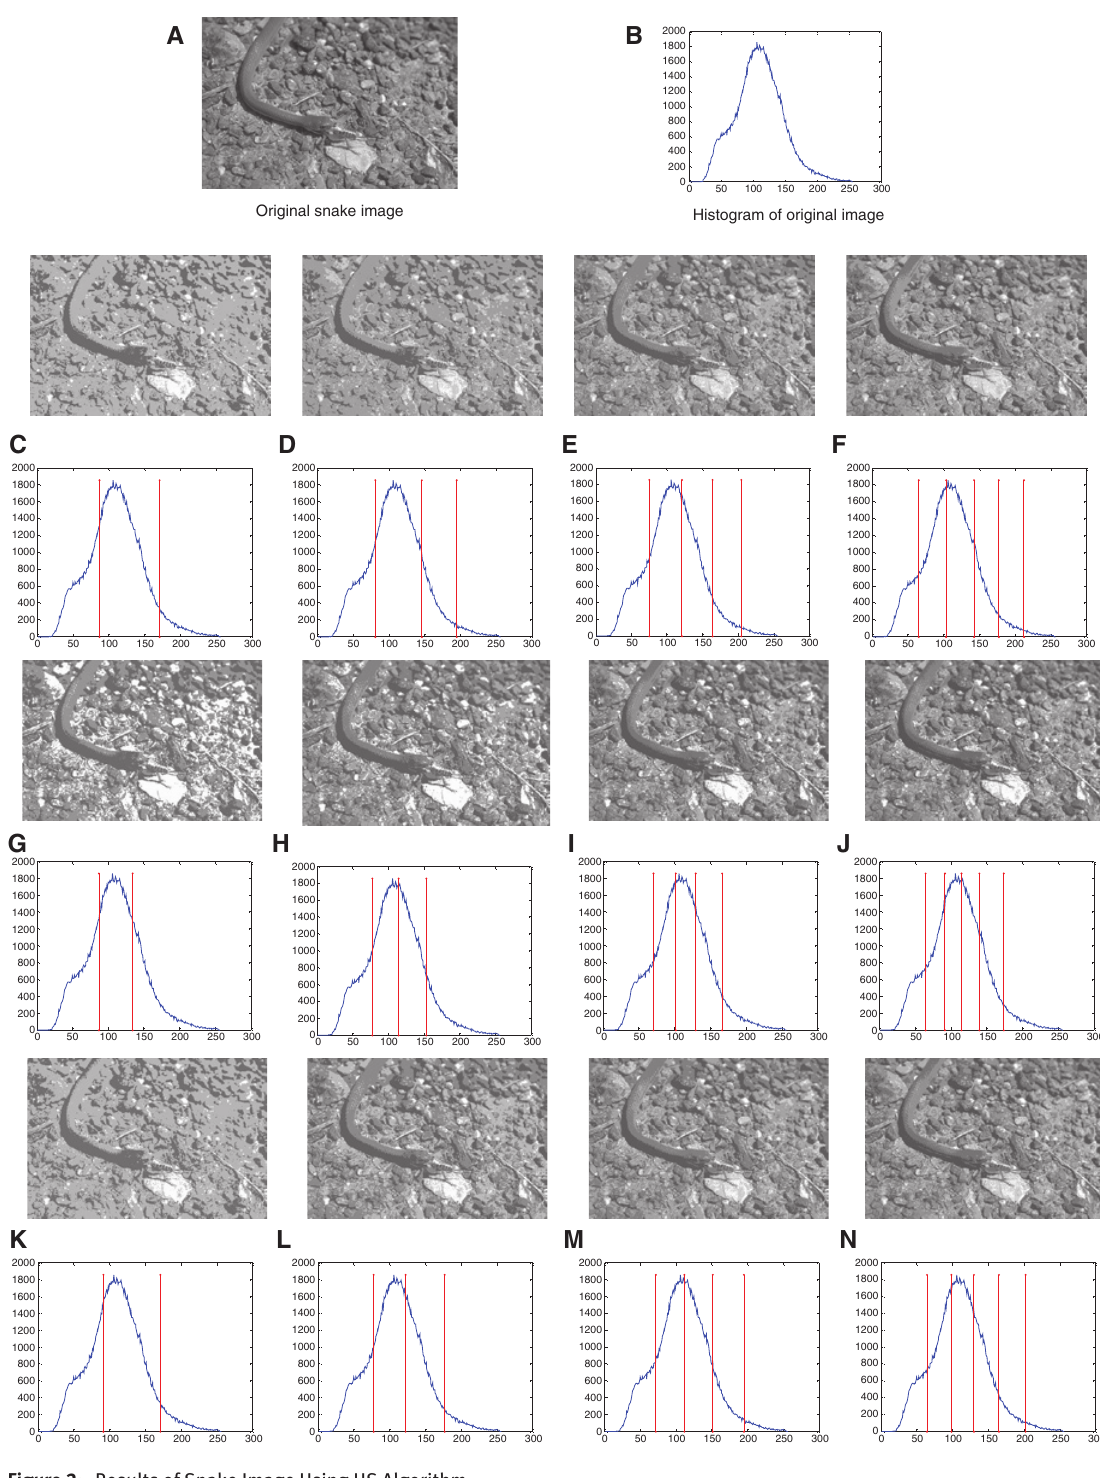
Figure 2: Results of Snake Image Using HS Algorithm. (A) Original snake image, (B) histogram of original image, (C–F) two-level to five-level thresholding-based segmented image with the best thresholds obtained from HS algorithm using Kapur’s entropy criterion, (G–J) two-level to five-level corresponding histogram labeled with the best threshold values obtained from HS algorithm based on the between-class variance criterion, (K–N) two-level to five-level thresholding-based segmented image with the best thresholds obtained from the HS algorithm using Tsallis entropy